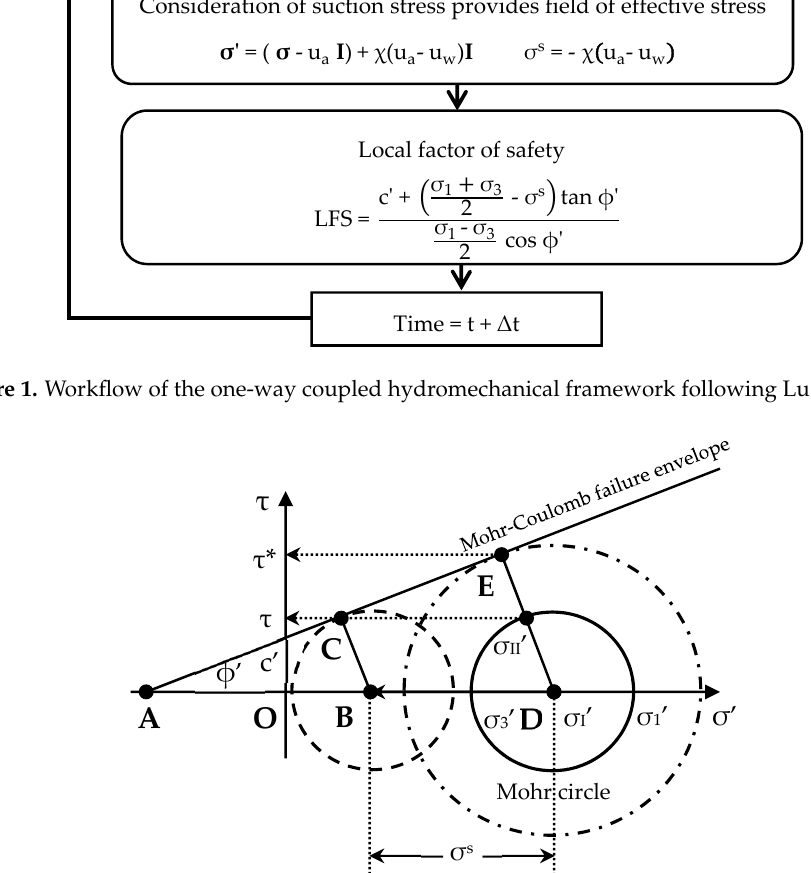
Figure 3. State of shear stress tensor and the corresponding Mohr circle.